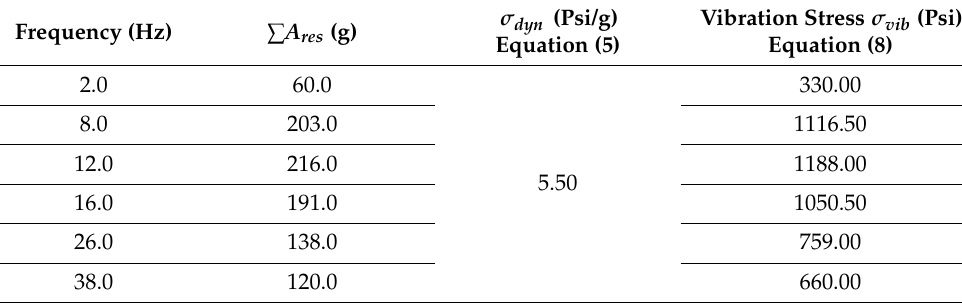
Table 3. Vibration stress results.